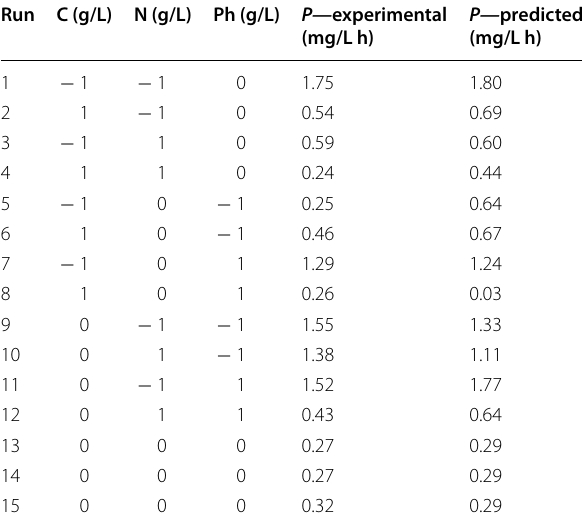
Table 2 Factor values for independent variables and response variable (experimental and predicted) of screening